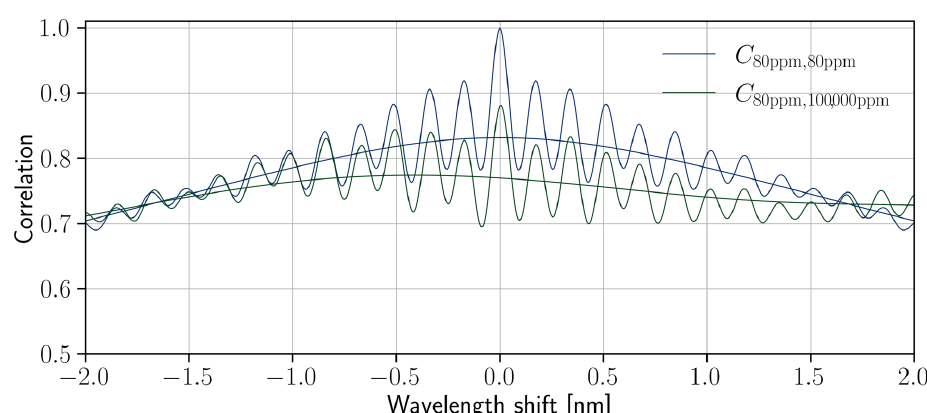
Figure 4. Correlation functions between spectra of different solutions and after their smoothing with a 0.6 nm Gaussian filter. Blue lines correspond to the autocorrelation function of the 80 ppm solution (almost pure water). Green lines correspond to the correlation of the 80 ppm and 100,000 ppm solutions’ spectra. It can be observed that the peak of the smoothed green line is significantly shifted from the origin.